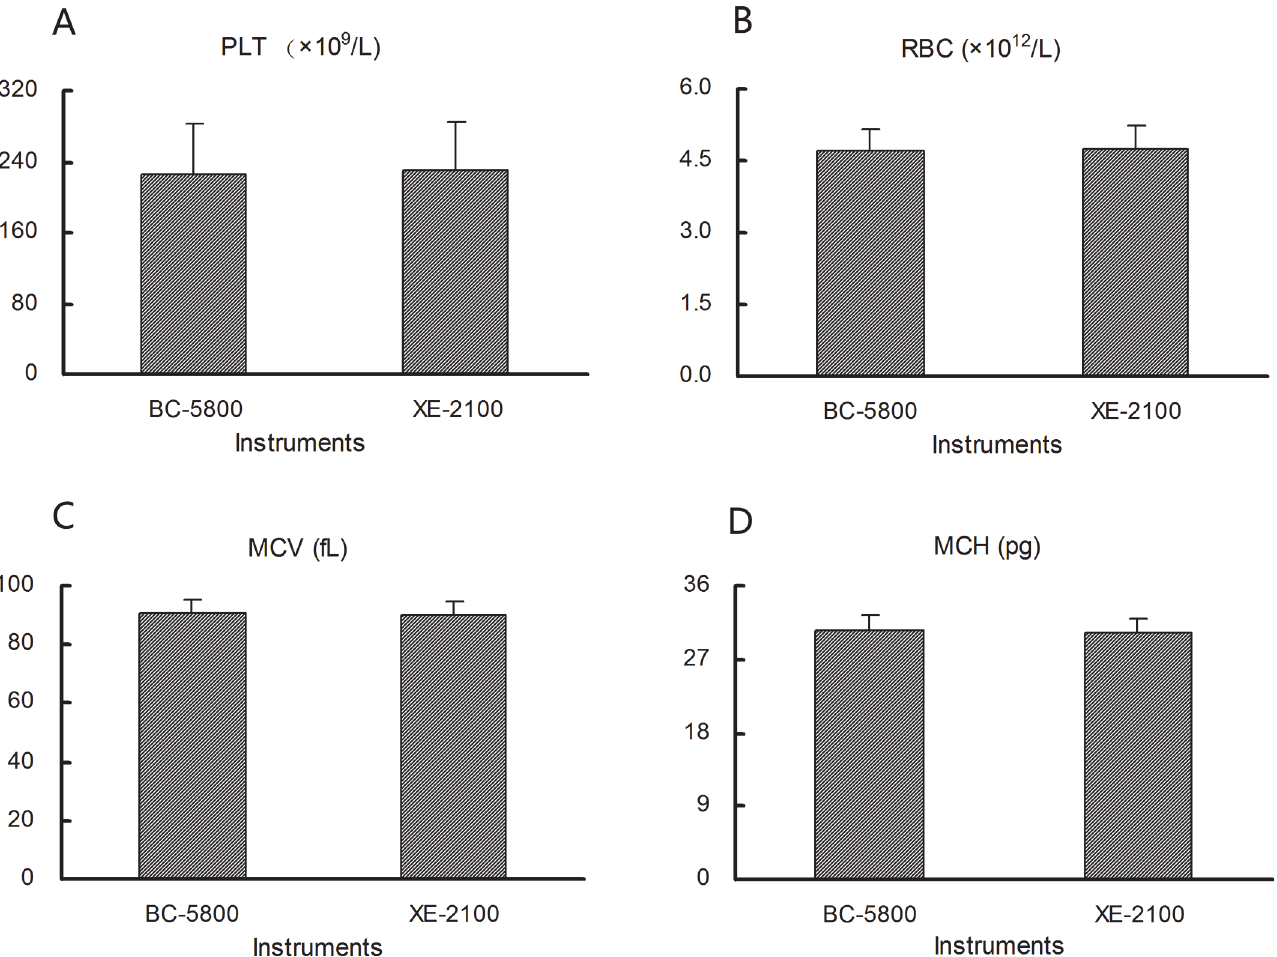
Fig 2. Mean platelet count (PLT, A), red blood cell count (RBC, B), mean corpuscular volume (MCV, C), and mean corpuscular hemoglobin (MCH, D) value according to the use of different